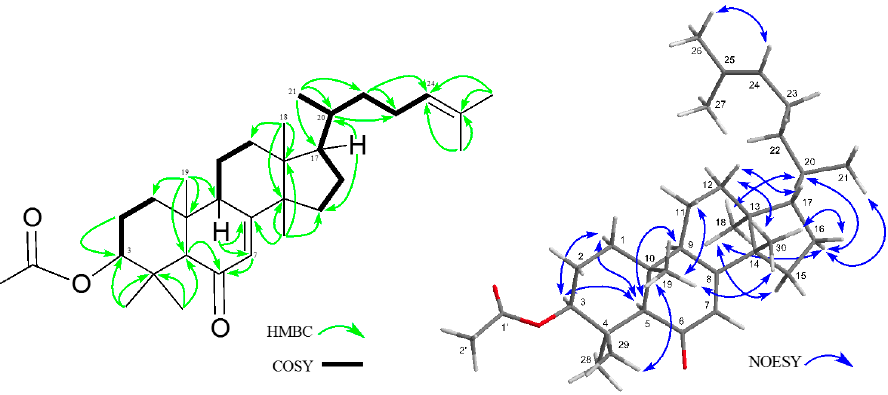
Figure 4. Key HMBC, COSY, and NOESY correlations for 3 .